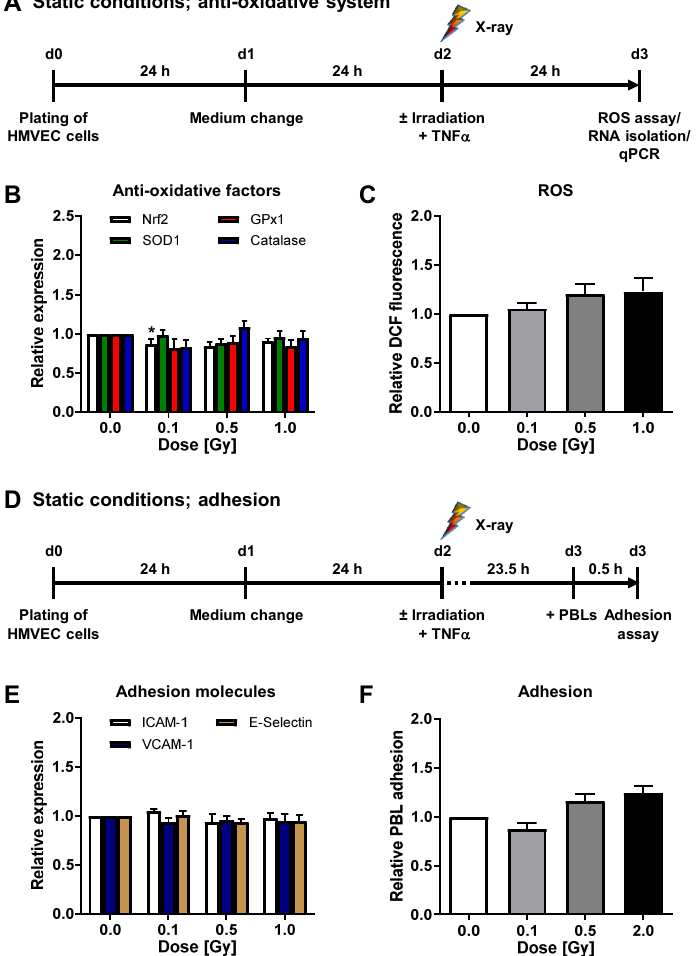
Figure 2. X ‐ irradiation under static conditions does not modulate the mRNA expression of anti ‐ oxidative enzymes in HMVEC cells nor PBL adhesion. ( A ) HMVEC were plated and incubated for 24 h. Medium was changed 24 h before irradiation and TNF ‐α treatment and ROS measurement and RNA isolation were performed at 24 h thereafter. ( B ) mRNA expression of anti ‐ oxidative factors was evaluated by qPCR (mean + SEM; n = 5–6 * p < 0.05; Kruskal ‐ Wallis test vs. 0 Gy). ( C ) Intracellular ROS were measured by flow cytometry (mean + SEM; n = 12). ( D ) Schematic setup of adhesion experiments. ( E ) mRNA expression of indicated adhesion molecules was measured by qPCR (mean + SEM; n = 6). ( F ) Microscopic evaluation of PBL adhesion was performed after fixation and DAPI and phalloidin ‐ TRITC staining and values, relative to non ‐ irradiated samples are shown (mean + SEM; n = 9). To verify our findings on mRNA expression level, we measured the cell surface protein expression of cell adhesion molecules. Irradiation under laminar conditions resulted in a slightly reduced surface expression of VCAM ‐ 1 and E ‐ Selectin after 0.1 Gy irradiation (Figure 3A). In concordance with the above ‐ described findings on mRNA level,